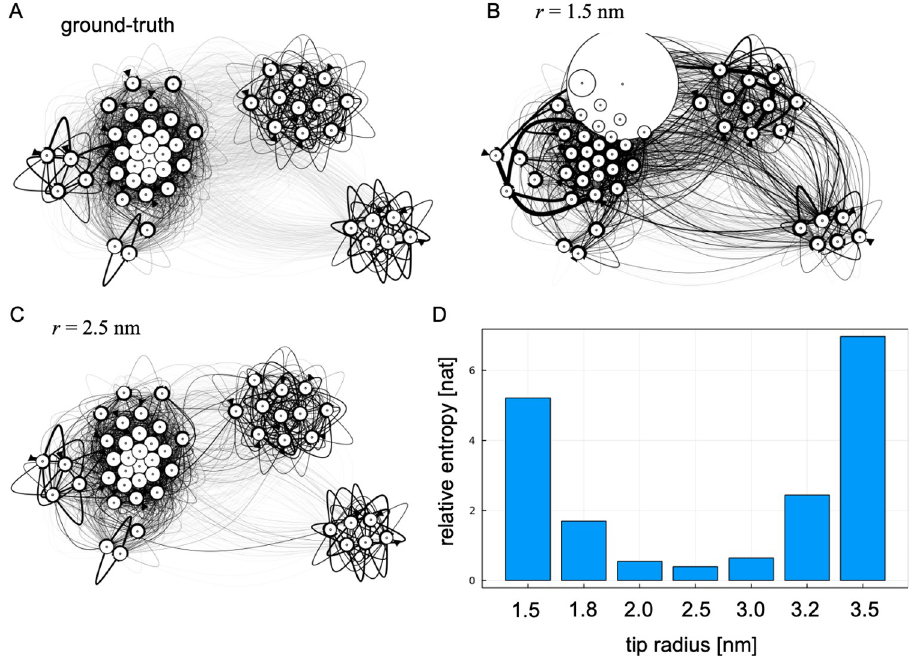
Fig 6. Reconstruction of MSM from atomic force microscopy data. (A) Graph representation of the ground-truth MSM used for twin experiments. (B) Reconstructed Markov state model with the tip apex radius of 1.5 nm. (C) Reconstructed MSM with the tip apex radius of 2.5 nm (the ground-truth radius). (D) Accuracies of reconstructed msms evaluated by relative entropies for various tip apex radii.